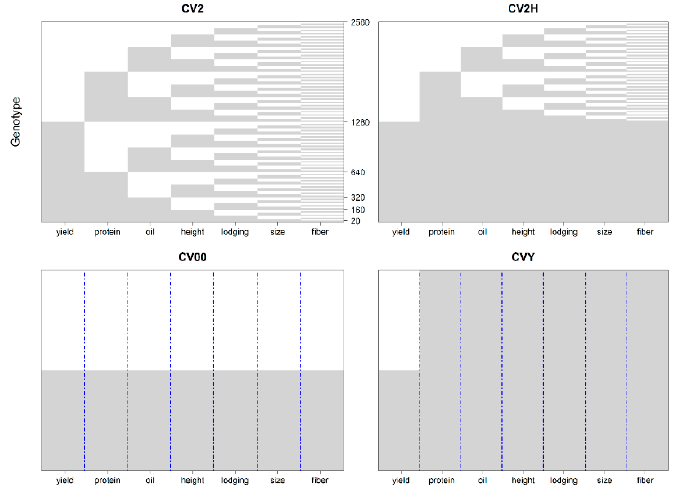
Figure 1. Graphical representation of four di ff erent cross-validation designs; horizontal gray blocks of lines (20 per block) correspond to those genotypes assigned to the training set while the horizontal blocks of white lines (20 per block) conform the testing set. CV2: for each trait, half of the phenotypic information was assigned to the training set while the remaining half to the testing set, such that this design allows di ff erent degrees of overlapping across traits for genotypes varying between no phenotypic information (20 genotypes) and information on all the 7 traits (20 genotypes). CV2H: similar to the previous scheme; however, there is phenotypic information available on all the traits for those genotypes with available yield records (training set for yield). CV00: there is phenotypic information available across traits only for those genotypes with yield records. CVY: There is phenotypic information on grain yield for half of the genotypes while full information for the remaining traits (6). Table 1. Strategies (model-cv scheme) for predicting yield performance and associated traits (AT) for different approaches (S, single-trait; M multi-trait) and different training/testing sizes (further details in Figure 1).